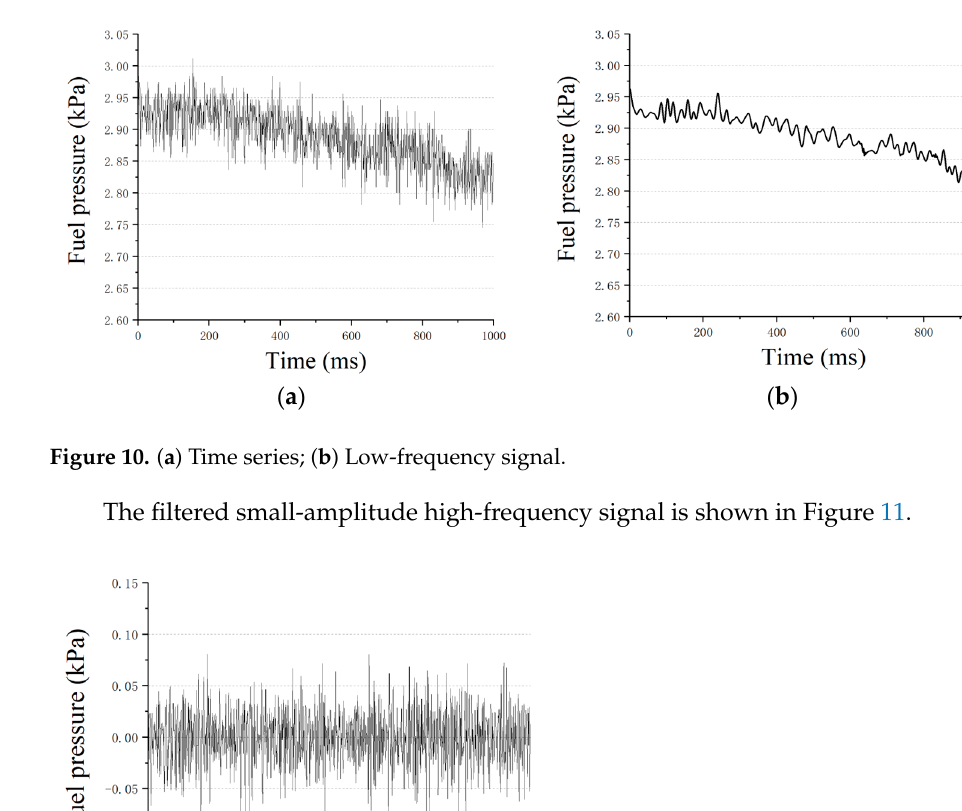
Figure 10. ( a ) Time series; ( b ) Low-frequency signal. The filtered small-amplitude high-frequency signal is shown in Figure 11.